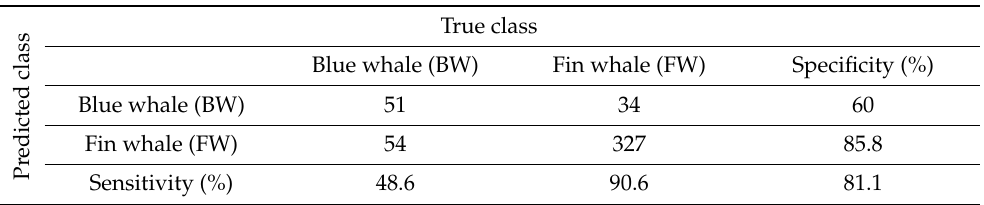
Table 8. The confusion matrix associated with the comparison method I for the ‘Blue whale (BW) + Fin whale (FW)’ dataset (the accuracy (%) is indicated in bold font and calculated as a ratio of the sum of diagonal values to the sum of all values × 100).